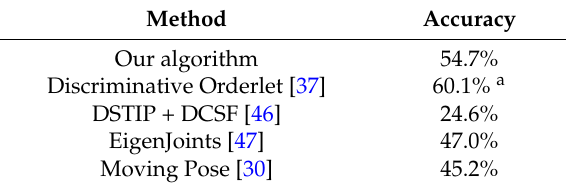
Table 3. Comparison of continuous human action recognition results on MSR Daily Activity 3D